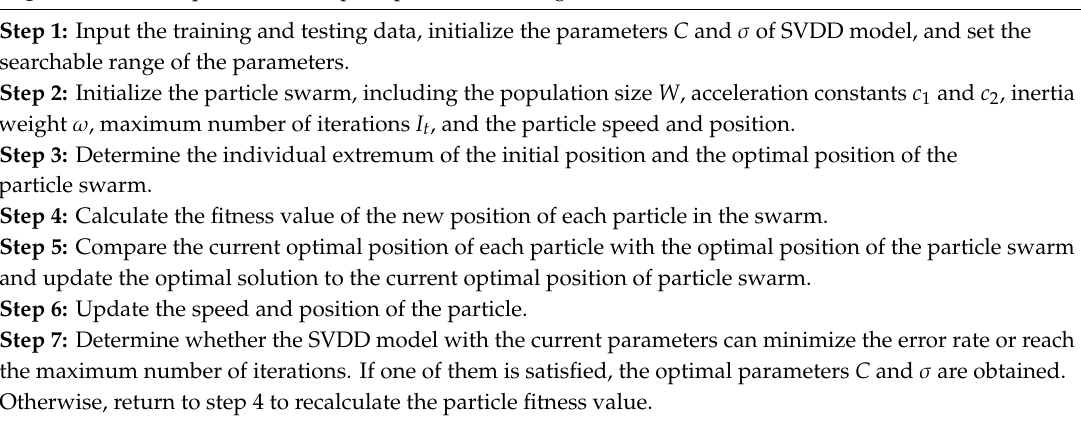
Algorithm 1. The optimization steps of parameters using